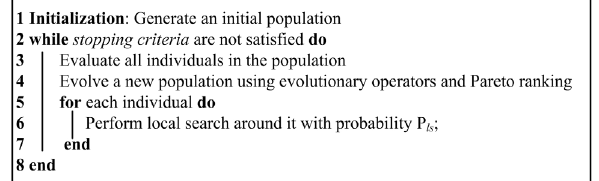
Figure 2 General framework for